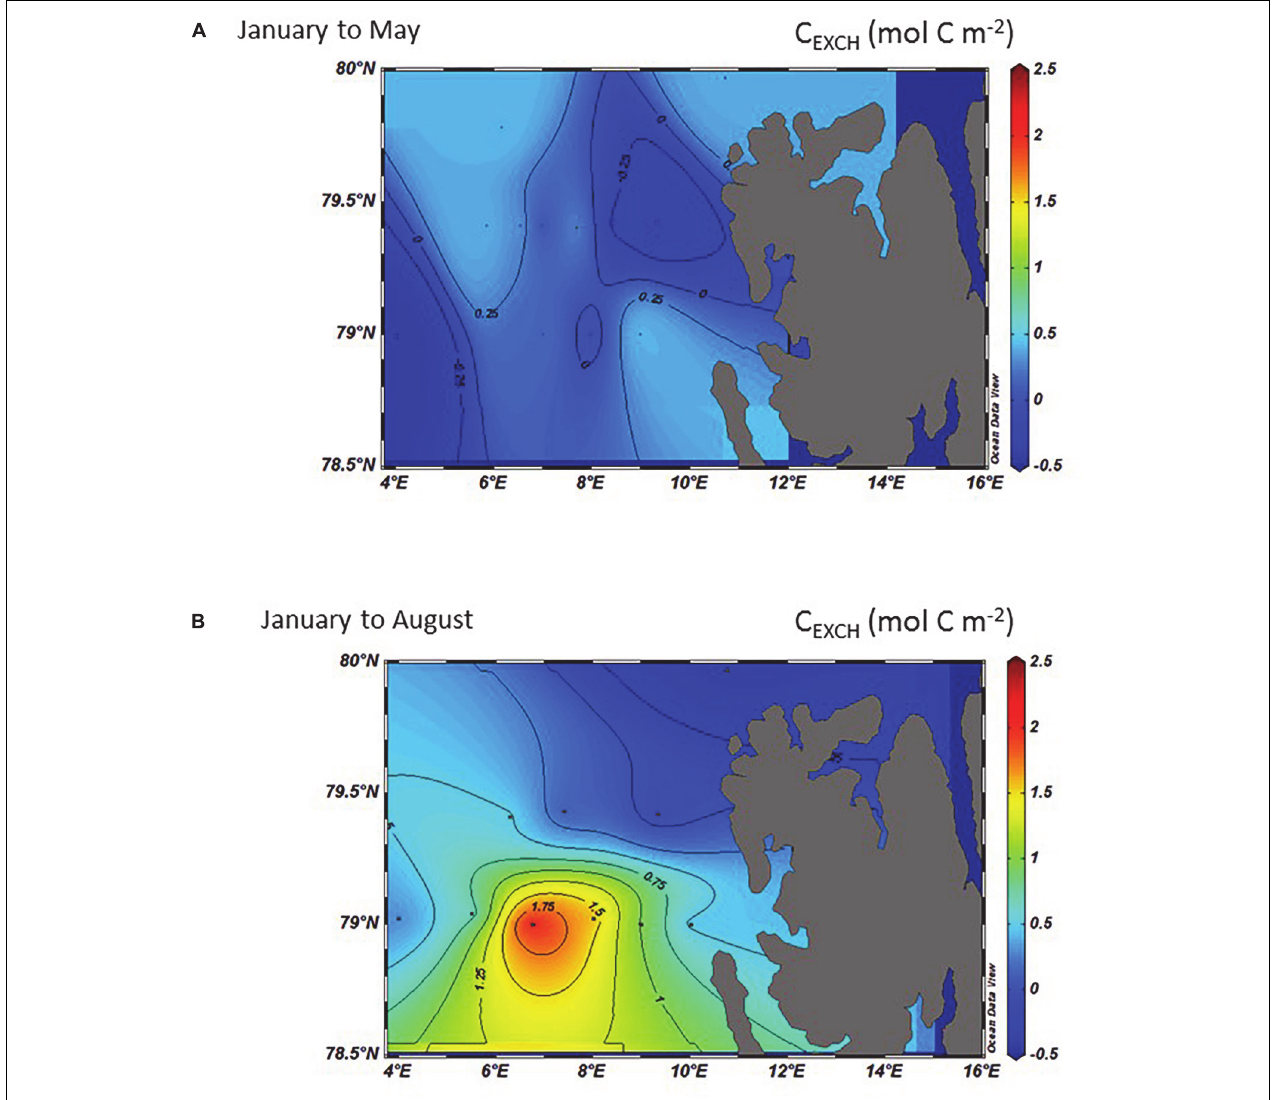
FIGURE 9 | The interpolated and integrated C EXCH in the top 50 meters (mol C m − 2 ) in 2014 calculated from the difference between January and: (A) May and, (B) August 2014. Negative numbers denote an ocean CO 2 sink from the environment, such as uptake from the atmosphere, and positive numbers denote an ocean CO 2 outgassing and source to the